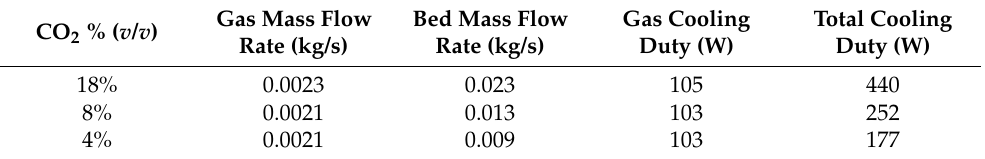
Table 5. Simulated moving bed energy duties and bed flow rate for various CO 2 concentrations using the mass flow balance model (Equation